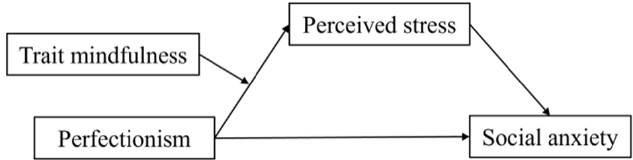
Figure 1. The hypothetical model.